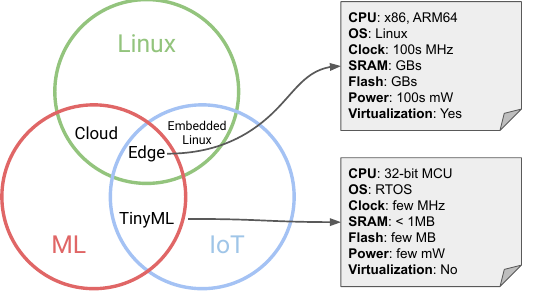
Figure 1. Overlapping of technological areas. Image inspired by Figure 1 in